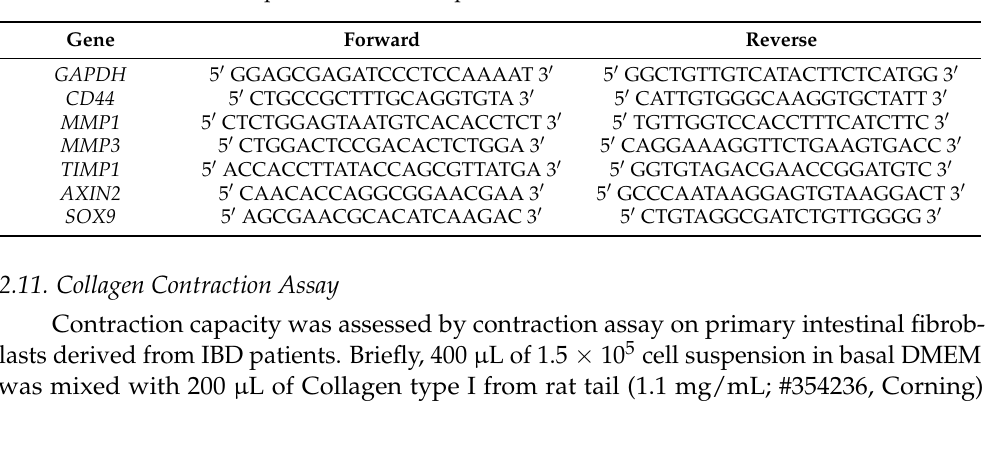
Table 2. List of the human primers utilized to perform